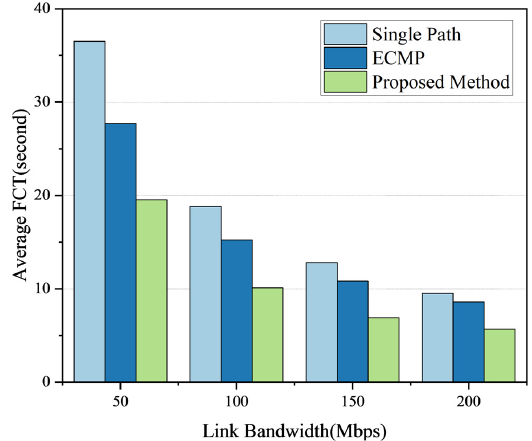
Figure 6. The average FCT under different link bandwidths.